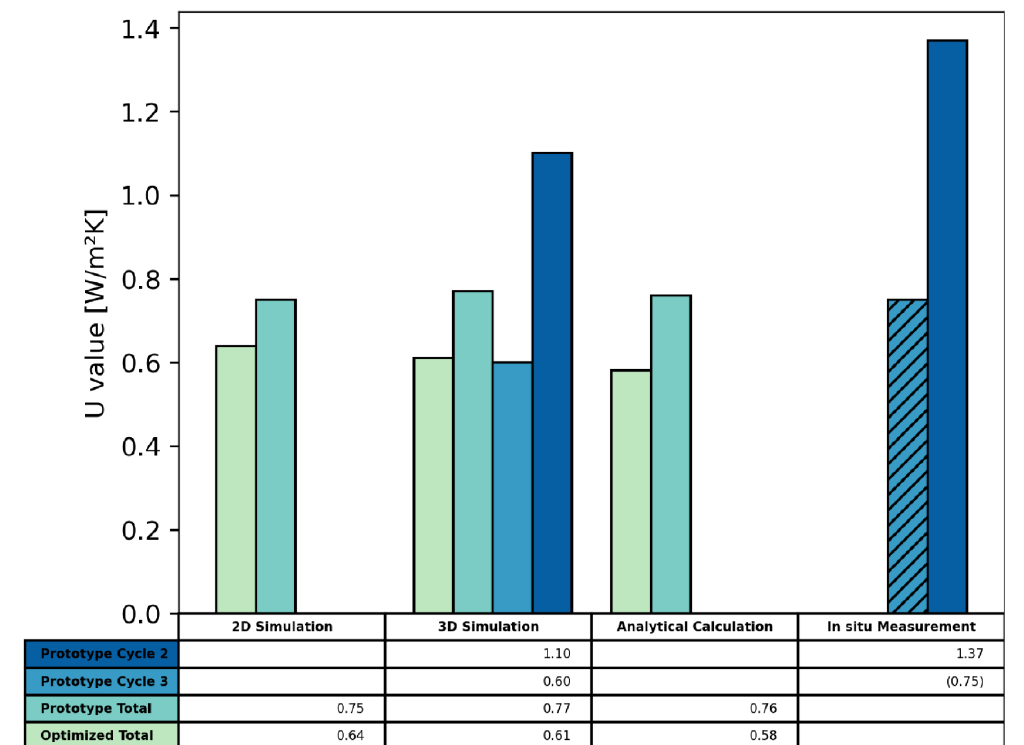
Figure 13. Comparison of the resulting U-values (W/m 2 K) for 2D simulations, 3D simulations, analytical calculation, as well as in-situ measurements subdivided in local evaluation on the existing prototype at sensor locations of cycle 2 and 3 (with reservations due to exceeded thresholds), the total value for the whole existing prototype, and the optimized geometry.